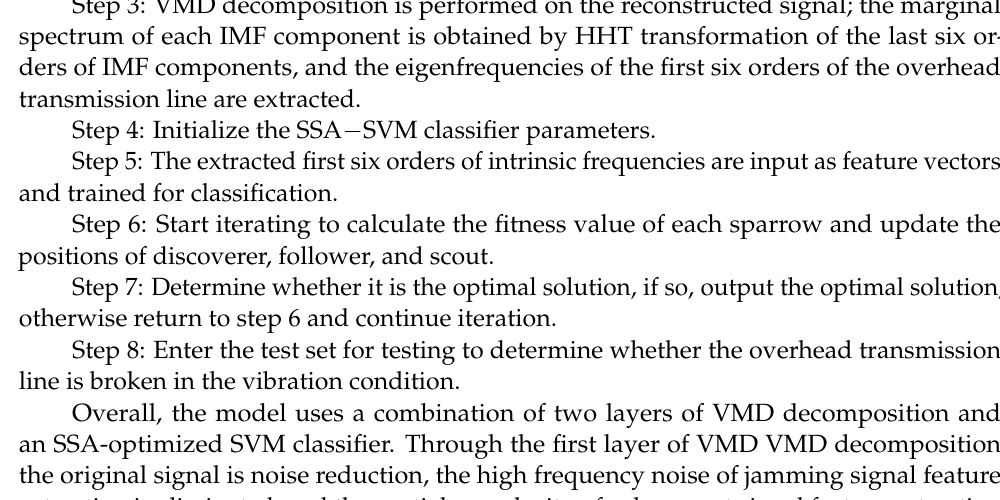
Figure 3. Simulation system model. In order to simulate the breeze vibration generated by the overhead transmission line in a breezy environment, it is necessary to simulate the breeze speed time curve, based on the “ Beaufort scale ” breeze wind speed of 3.4 m/s~5.4 m/s. The simulated wind speed time profiles are shown in Figure 3. In this paper, it is assumed that the wind load acts vertically with the transmission line along the Z − axis direction. Then use Ansys to carry out transient dynamics analysis on the model in the figure, transient dynamics analysis is to